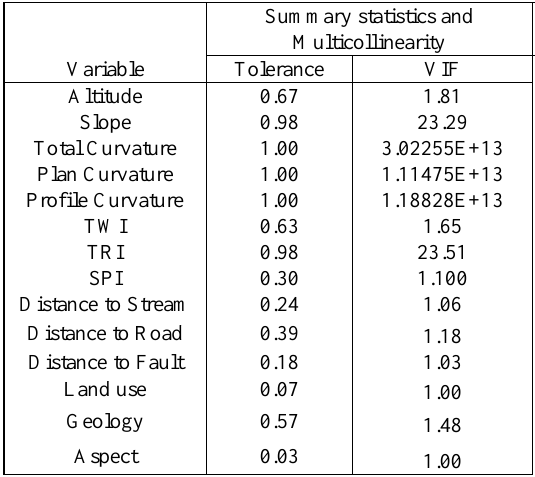
Table 2. Variance Inflation Factor (VIF) analysis